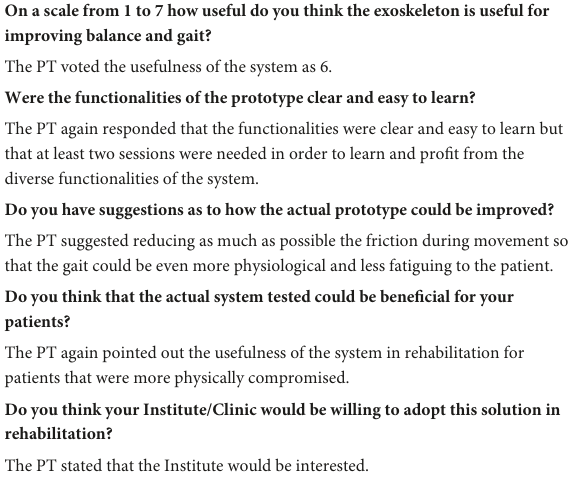
Which aspect of the exoskeleton did you like the most and why? With respect to the previous version tested, the PT found that knee extension was more stable during the stance phase and that the control of retroversion/anteversion of the pelvis was